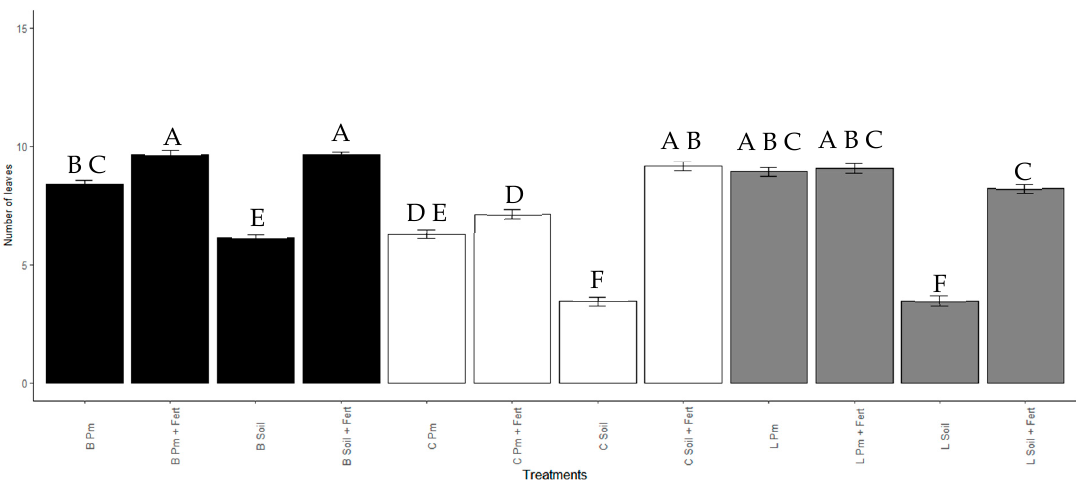
Figure 7. Number of leaves of Habanero pepper seedlings with or without inoculation with Enterobacter sp. ITCB-09 after 60 days of cultivation. The di ff erent letters on the bars indicate significant di ff erences ( p < 0.001) based on Bonferroni comparisons; whiskers represent the standard errors. Black bars indicate the treatments with pearls ( Enterobacter sp. ITCB-09); white bars indicate the controls; gray bars indicate the treatments with liquid ( Enterobacter sp. ITCB-09).